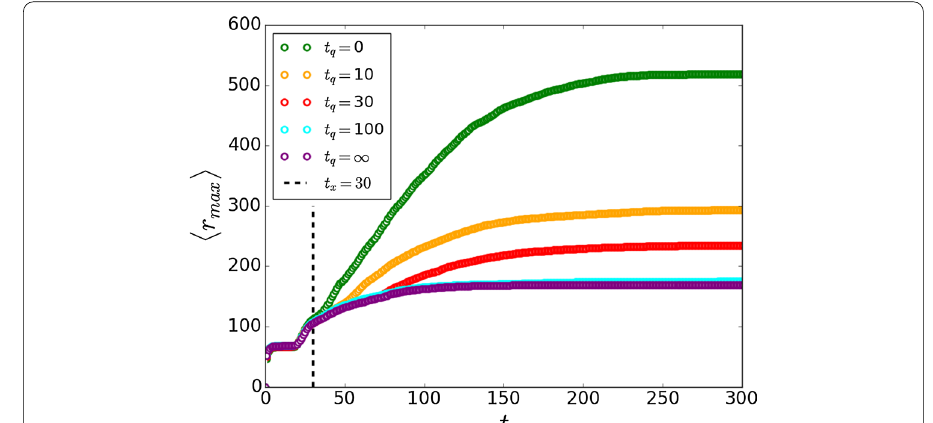
Fig. 6 Temporal quarantine strategy. Here we show the effect of quarantine strategy within cities (Fig. 5b) for different quarantine time windows t q . At time t x = 30 we temporally reduce K → K ′ within cities (black dashed line) and at time t x + t q remove the quarantine K ′ → K . The quarantine window highly affects the final extent of the epidemic, (cid:31) r max (cid:30) f , and while early removal of the quarantine will result with the epidemic still propagating in the system, a finite quarantine window can completely stop the propagation of the disease with � r max � f ≈ � r max � x . Here we used ζ = 100 , K = 4 , K ′ = 3 , k inter = 10 − 3 , L = 1000 and β = β 2